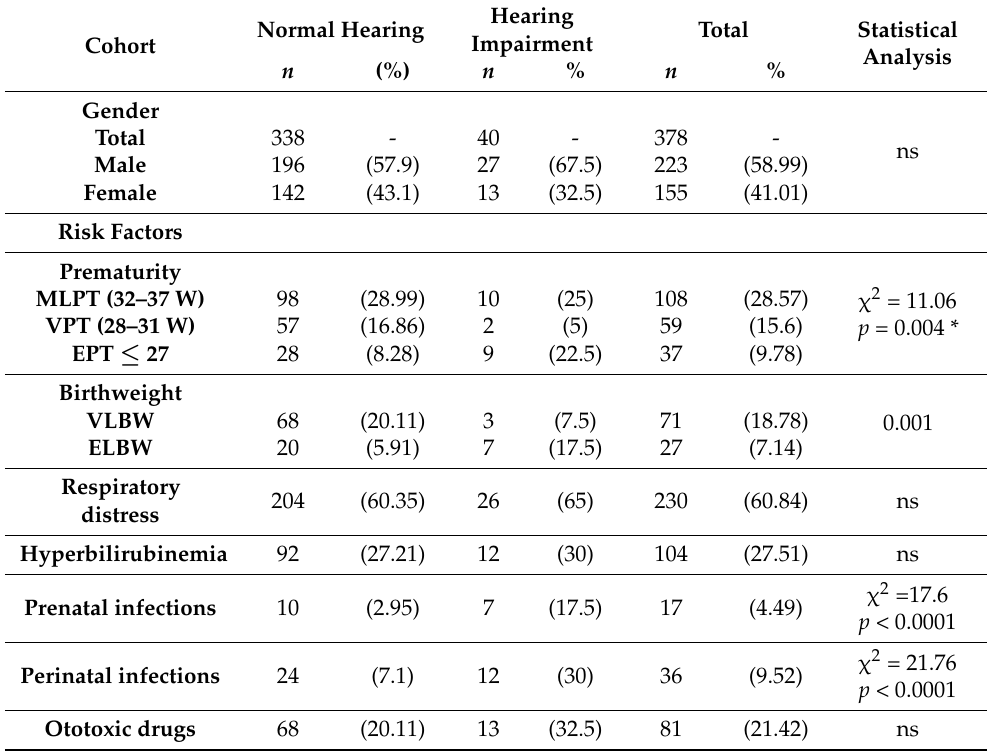
Table 1. Demographic characteristics and risk factors of the NICU